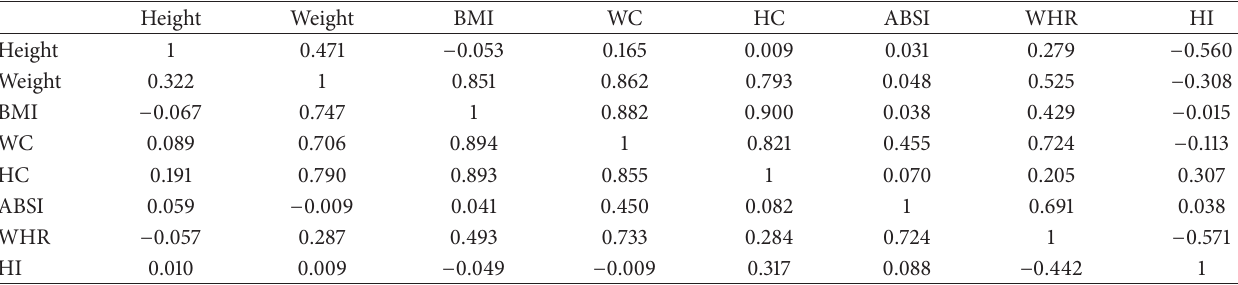
Table 2: Correlations of body measures in